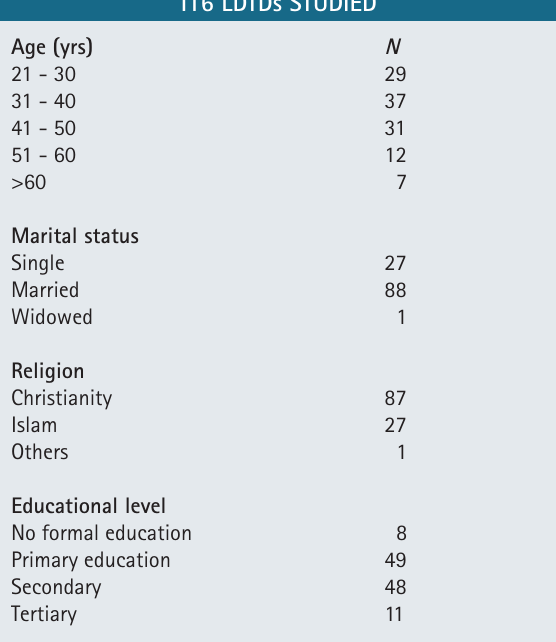
taBle i. Socio-DeMograPHic cHaracteriSticS oF 116 lDtDs StUDieD